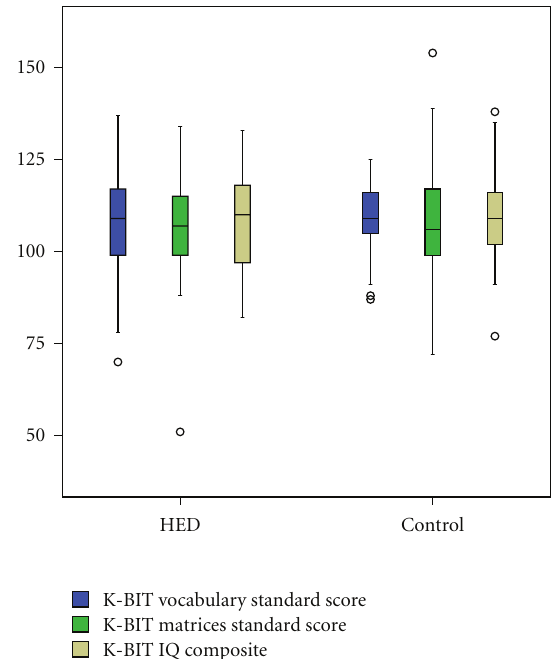
Figure 1: K-BIT standard scores for verbal (vocabulary), nonverbal (matrices), and full-scale (composite) intelligence quotient (IQ) among children with HED and control